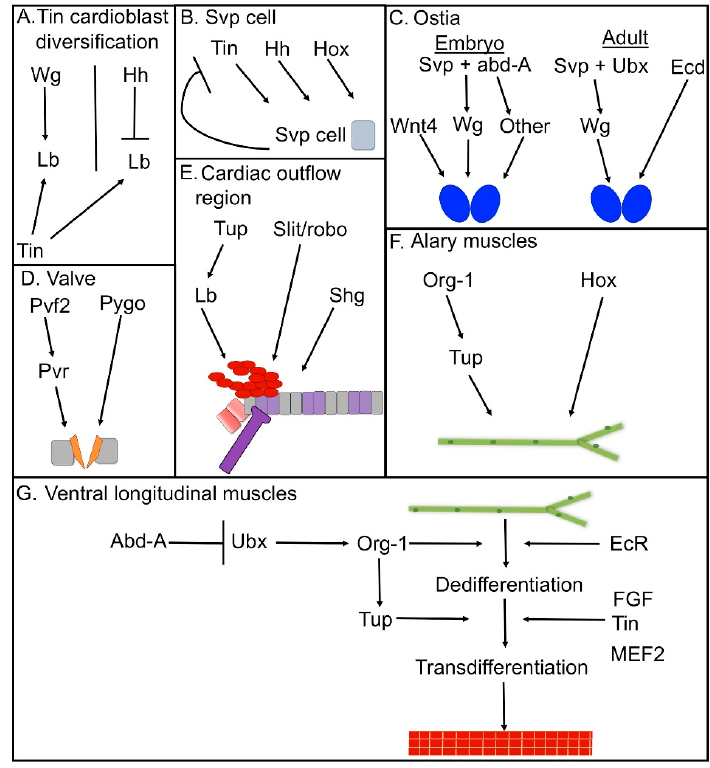
Figure 2. Genes and pathways required for the formation of cardiac structures discussed in this review. ( A ): Diversification of Tin cardioblasts; ( B ): Specification of Svp cells; ( C ): Specification of ostia; ( D ): Specification of the cardiovascular valve; ( E ): Specification of the cardiac outflow region; ( F ): Specification of the alary muscles; ( G ): Formation of the ventral longitudinal muscles of the adult heart.